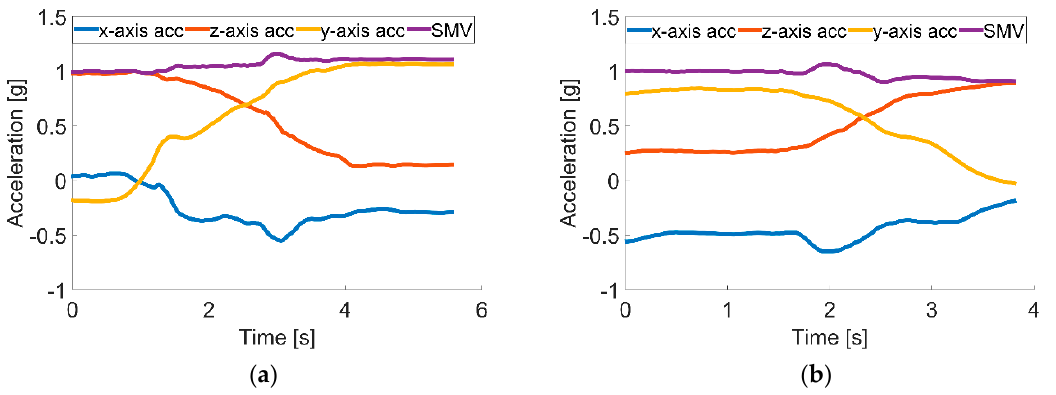
Figure 14. Accelerations in the x -, y - and z -axes and SMV readings during activities: ( a ) lying down; ( b ) getting up. Table 3. Activity recognition accuracy.